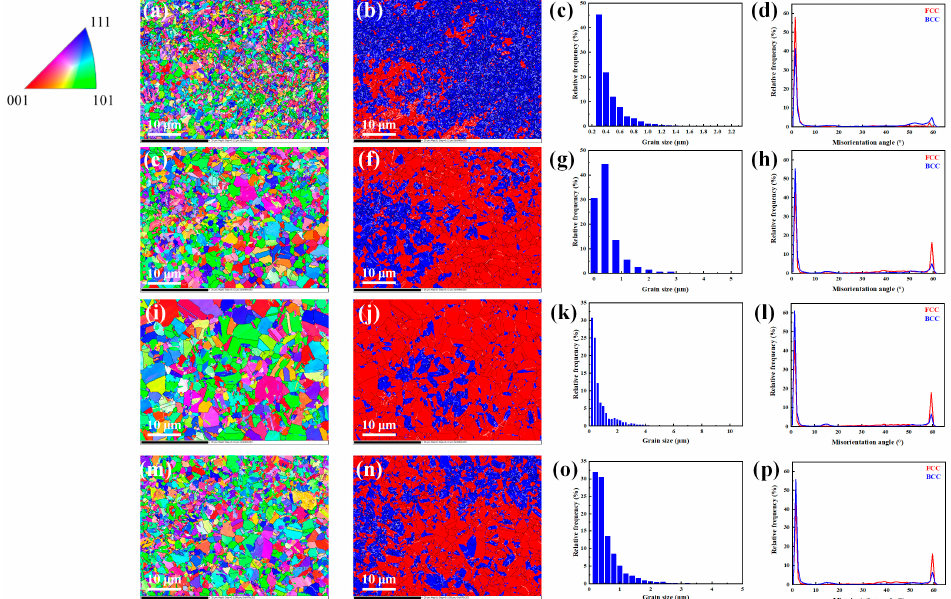
Figure 16. IPF, phase maps (red areas—FCC, blue areas—BCC), grain size, and misorientation angle of the specimens, respectively: ( a – d ) A1, ( e – h ) A2, ( i – l ) A3, and ( m – p ) A4. The simulated equilibrium phase compositions of the steels with different composi- tions, at different temperatures, calculated with the Thermo Calc software, are shown in Figure 17. The following conclusions can be drawn: (i) the matrix of Fe–13.5Cr–2W was fully ferritic at any temperature, under the ideal conditions; (ii) the presence of O would not affect the phase transformation of the matrix at high temperature, but would result in the formation of oxides; (iii) C and N would lead to α → γ transformation at high temper- ature; (iv) C, N, and O would lead to the formation of M 23 C 6 , Cr 2 O 3 , M 7 C 3 , M 2 (C,N), and other precipitates. It should be noted, that the simulation results were in equilibrium, but the actual preparation process of the steels was a non-equilibrium transformation. A great deal of austenite was not able to transform back to ferrite, due to the rapid cooling rate and the γ -Fe stabilization effect of W. Therefore, the simulation results were approxi- mately consistent with the experimental results, for the phase structure at RT. Addition- ally, as for the composition of precipitates, the simulation results were also generally con- sistent with the experimental observations.